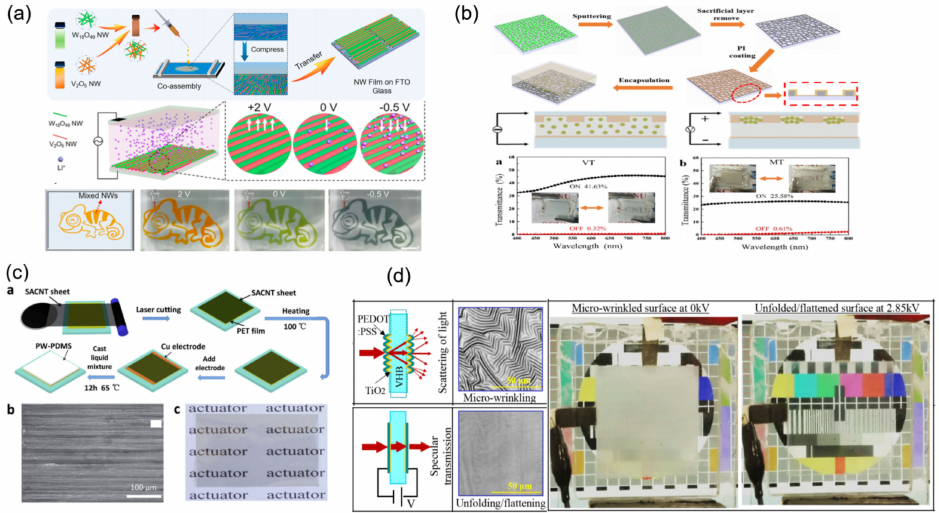
Figure 10. The strategy of electric driving mode mechanoresponsive smart windows: ( a , b ) controlling of nanoparticles via the electrophoresis to modulate colors and transmittance [64,65] Copyright 2021, American Chemical Society and 2021, Elsevier, ( c ) carbon nanotube-based materials to adjust trans- mittance [66] Copyright 2017, Elsevier, ( d ) based on surface wrinkle to modulate transmittance [67] Copyright 2018, American Chemical